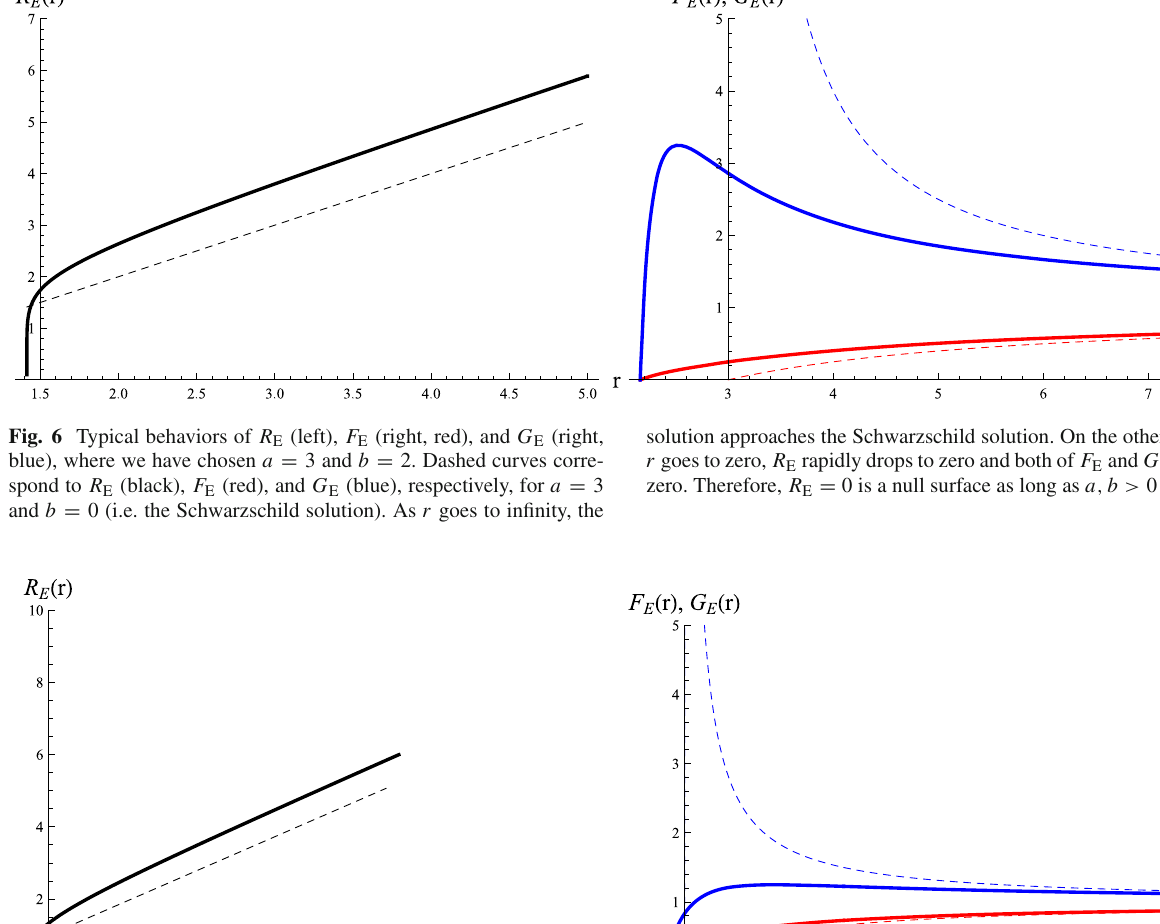
Fig. 7 Typical behaviors of R E (left), F E (right, red), and G E (right, blue), where we have chosen a = 1 and b = 2. Dashed curves correspond to R E (black), F E (red), and G E (blue), respectively, for a = 1 and b = 0 (i.e. the Schwarzschild